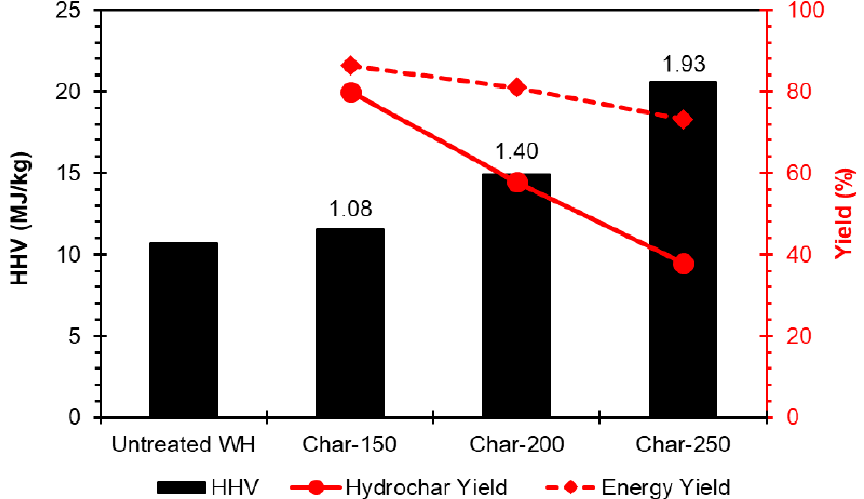
Figure 1. Untreated water hyacinth (WH) and hydrochar characteristics, including HHV (black bars), hydrochar yield (red circles), and energy yield (red diamonds). The numbers above the bars represent